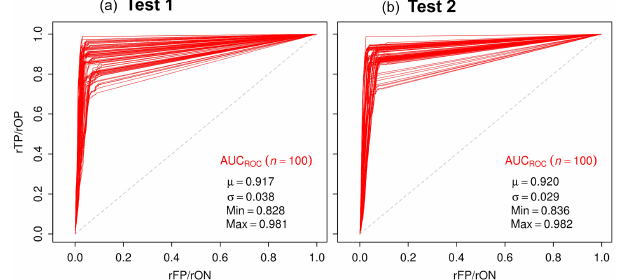
Figure 12. ROC plots illustrating the prediction quality of (a) test 1 and (b) test 2, using the original number of TN pixels (see Sect.